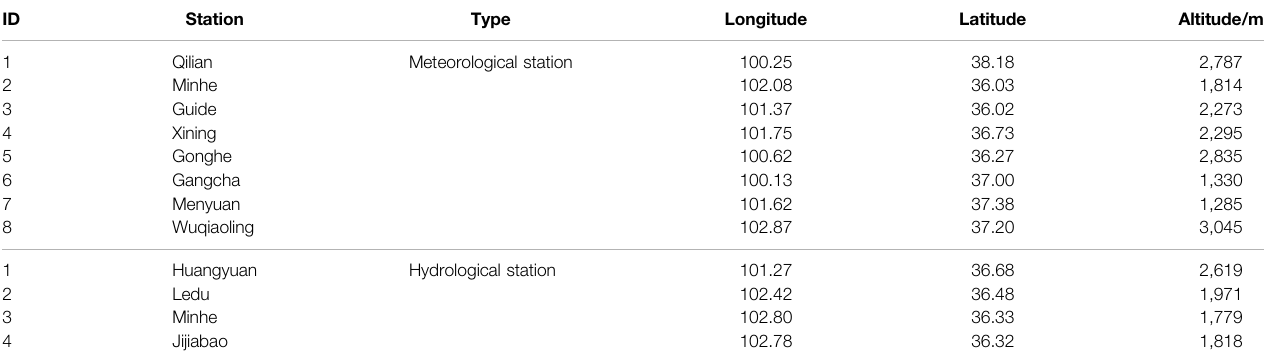
TABLE 1 | The overview of hydrological and meteorological stations in the Huangshui River